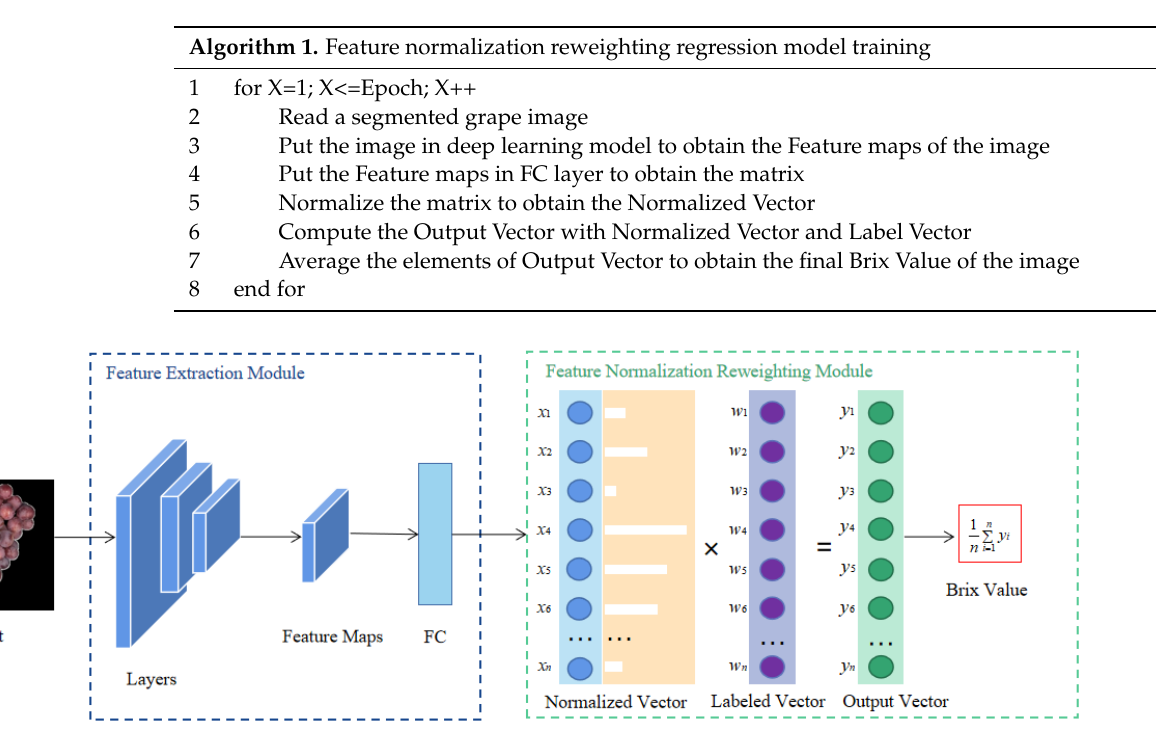
Figure 4. Overview of the feature normalization reweighting regression (FNRR) model architecture. Algorithm 1. Feature normalization reweighting regression model training